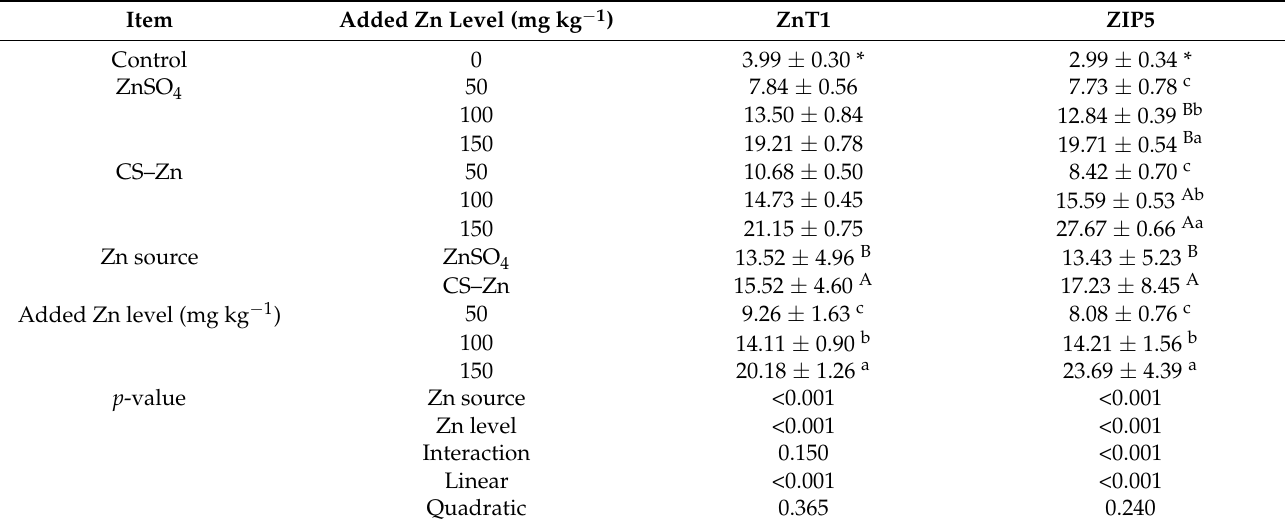
Table 4. Effects of dietary Zn source and level on the protein expressions of ZnT1 and ZIP5 in duodenal mucosa of weaned